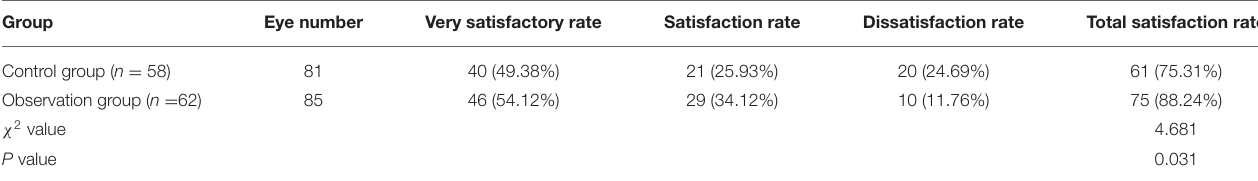
TABLE 3 | The satisfaction rate of two groups ( n , %).